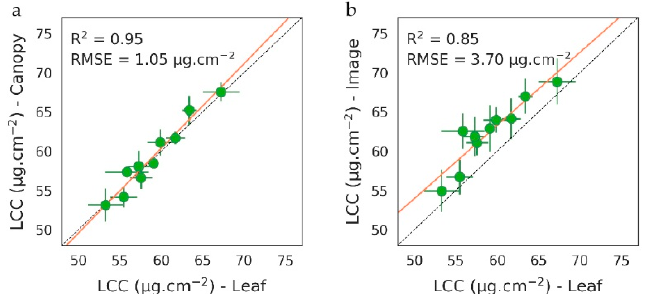
Figure 2. ( a – b ) Leaf chlorophyll content (LCC) (mean ± SD) retrieved from PROSPECT and PROSAIL model inversions on the 10 plots of the brownfield. ( a ) Comparison between leaf and canopy measurements from the field and ( b ) between leaf measurements and the airborne image.